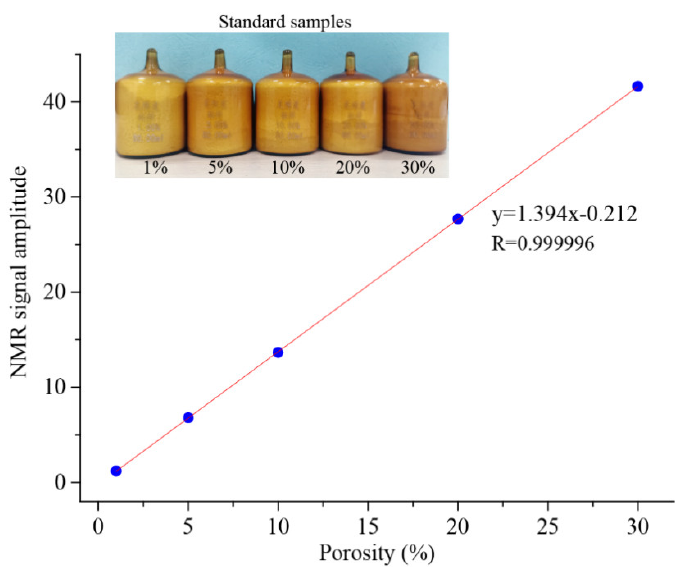
Figure 5. Calibration result fitting diagram of the standard samples.